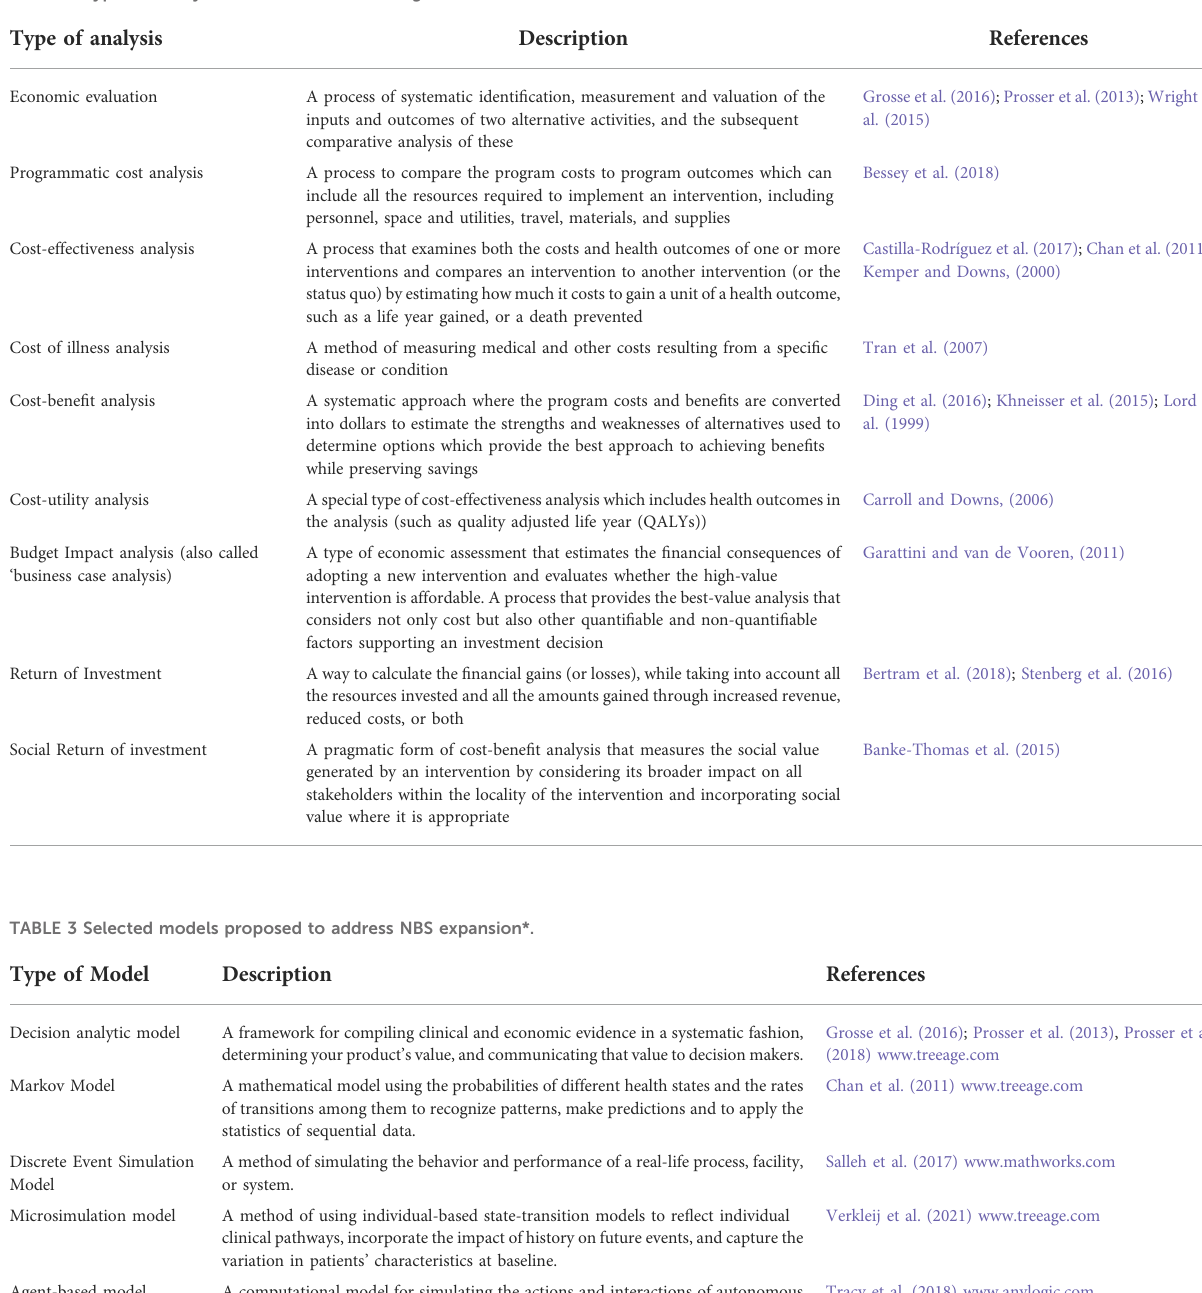
TABLE 2 Types of analysis derived from modelling.